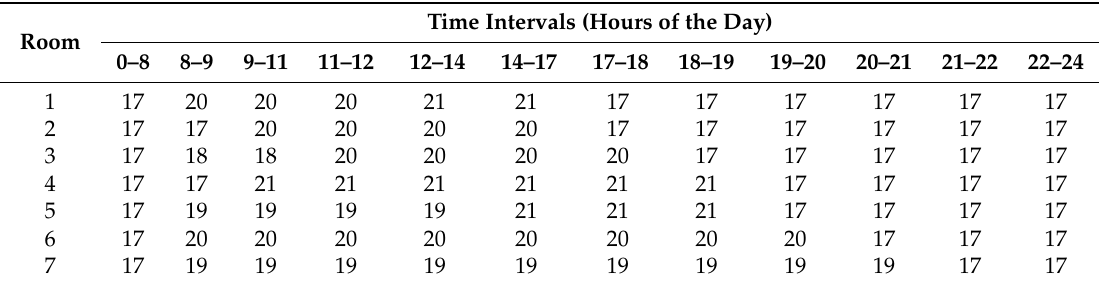
Table 3. Set-point values selected by the user for each room for one